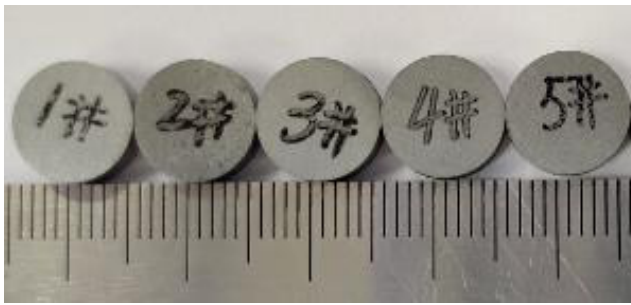
Figure 1. PAB specimens.